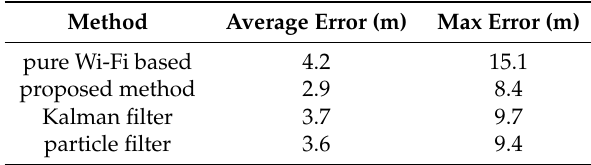
Table 1. The average and maximum positioning error comparisons using different